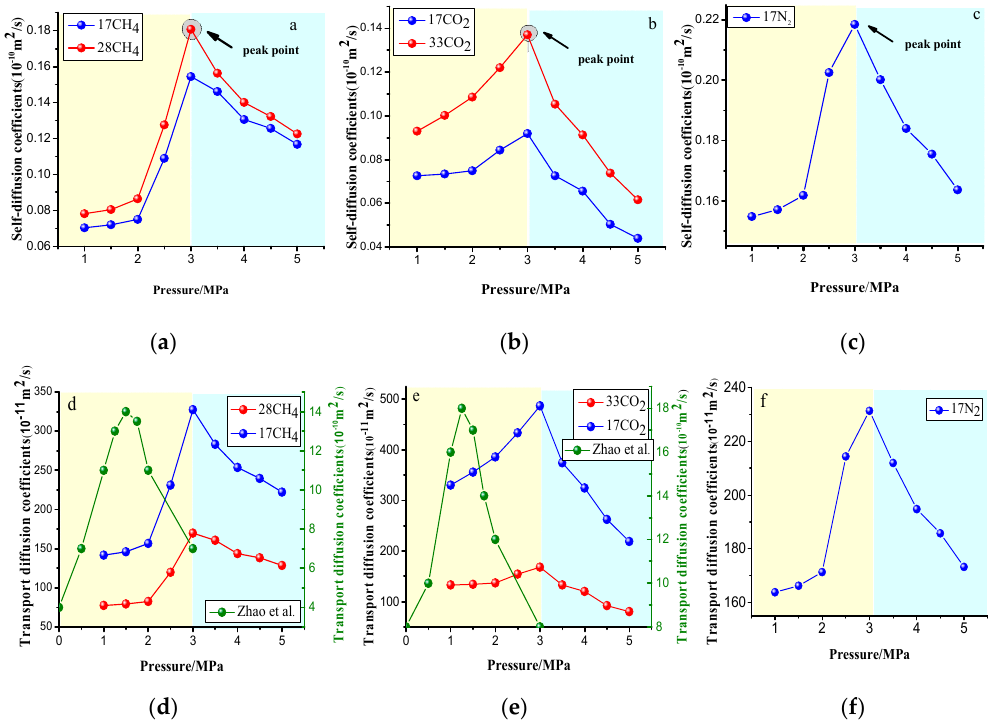
Figure 14. Pressure dependence of self- and transport diffusion coefficients at 0–5 MPa obtained through the molecular dynamics (MD) method. ( a ) the variation of CH 4 self-diffusion coefficient with pressure.( b ) the variation of CO 2 self-diffusion coefficient with pressure.( c ) the variation of N 2 self-diffusion coefficient with pressure.( d ) the variation of CH 4 transport diffusion coefficient with pressure.( e ) the variation of CO 2 transport coefficient with pressure.( f ) the variation of N 2 transport coefficient with pressure.